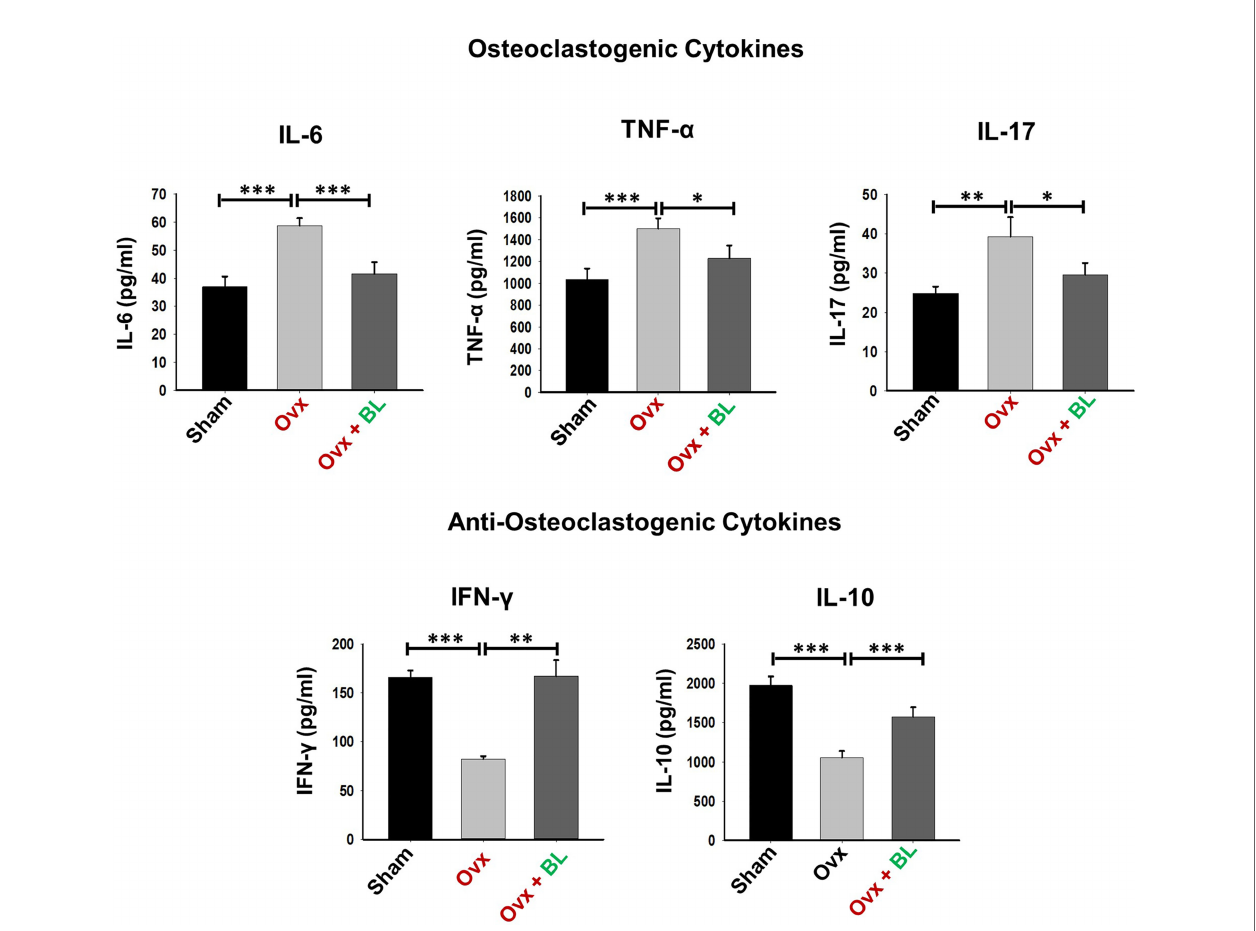
FIGURE 10 | BL modulates cytokine balance in Ovx mice. Osteoclastogenic cytokines were analyzed in serum samples of mice by ELISA. Anti-osteoclastogenic cytokines were analyzed in serum samples of mice by ELISA. The results were evaluated by using ANOVA with subsequent comparisons by Student ’ s t-test for paired or non-paired data, as appropriate. Values are expressed as mean ± SEM (n = 6), and similar results were obtained in two independent experiments. Statistical signi fi cance was de fi ned as p ≤ 0.05, *p ≤ 0.05, **p < 0.01, ***p ≤ 0.001 with respect to the indicated mouse